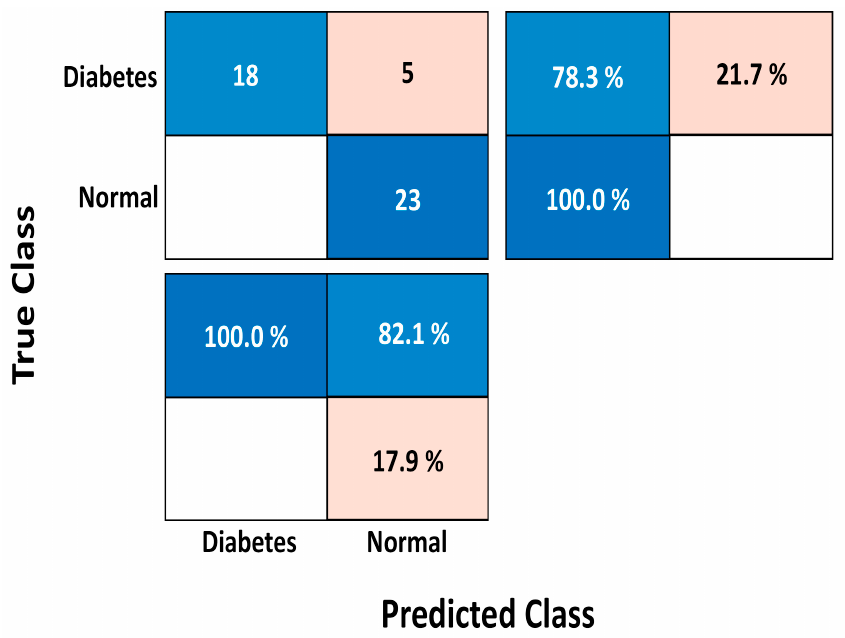
Figure 15. Confusion matrix for super vector machine with testing accuracy: 89.1034%.